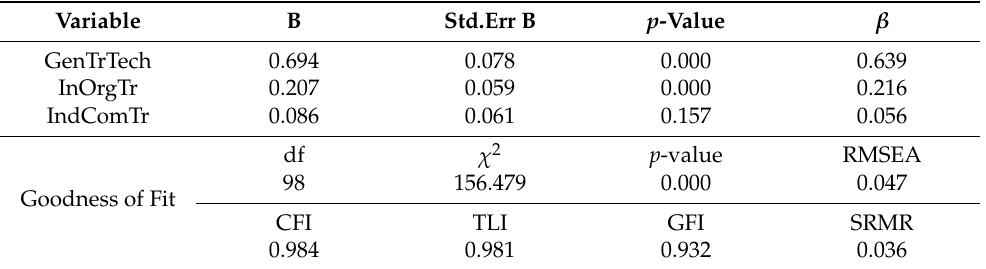
Table 3. Parameter estimation of the regression model for employees’ trust in AI in the